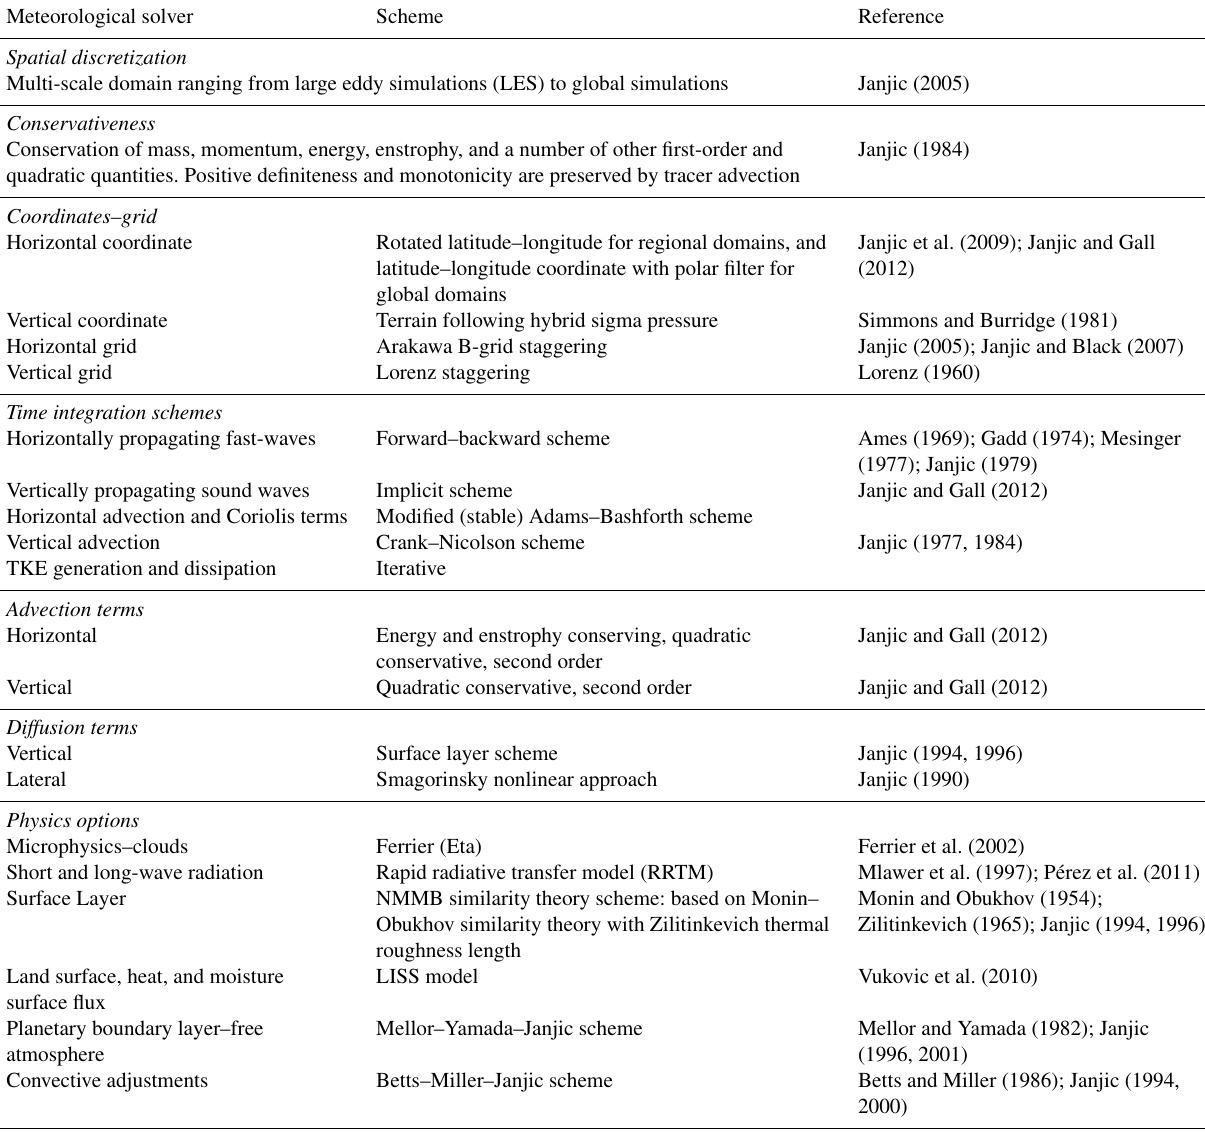
Table 1. Main characteristics of the NMMB-MONARCH-ASH meteorological solver. Meteorological solver